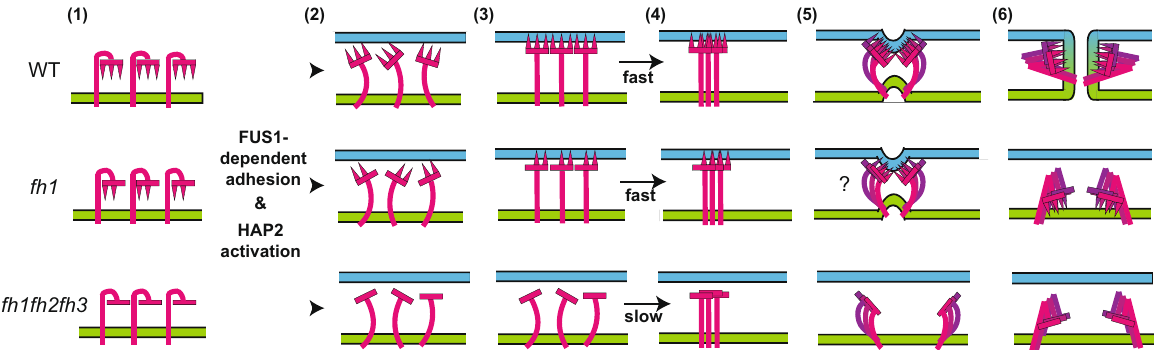
Fig. 6 Working model for transition of prefusion HAP2 into trimers in WT and fusion helix mutants. (1) Prefusion HAP2 with the 3 fusion helices of the fusion loop in a cryptic form on the membrane of the minus mating structure. The blue lines represent the membrane on the plus mating structure and the green lines represent the membrane on the minus mating structure. The magenta line with a trident on top represents one HAP2 monomer. Each spike of the trident represents the hydrophobic residues of one of the fusion helices. fh1 lacks hydrophobic residues in one fusion helix (middle panel) and the hydrophobic residues are missing in all 3 of the fusion helices of fh1fh2fh3 (lower panel). (2) FUS1-dependent interaction with the membrane of the plus mating structure (blue bar) allows HAP2 to transition to an extended monomeric intermediate with an exposed fusion loop. (3) The fusion loop of monomeric HAP2 interacts with the membrane of the plus mating structure, which promotes trimer formation in WT and fh1 but not in fh1fh2fh3 . (4) The trimeric, extended intermediate of HAP2 bridges the two membranes. (5) The extended trimer folds back, dragging the two membranes close. (6) Formation of the highly stable postfusion trimer is coupled with membrane merger in WT but not in fh1 or fh1fh2fh3